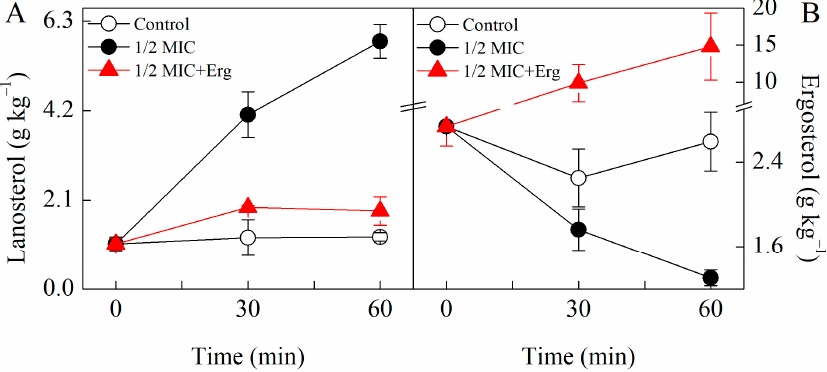
Figure 3. HPLC analysis of lanosterol ( A ) and ergosterol ( B ) contents in control samples, 1/2 MIC citronellal treated samples, and 1/2 MIC citronellal + Erg treated sample. The data presented are the means of pooled data. Error bars indicate the SDs of the means ( n = 3).